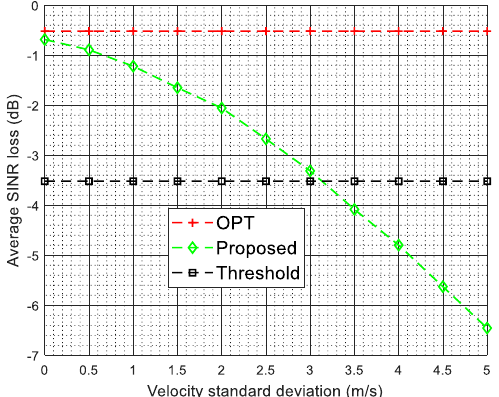
Figure 17. Average SINR loss versus the velocity standard